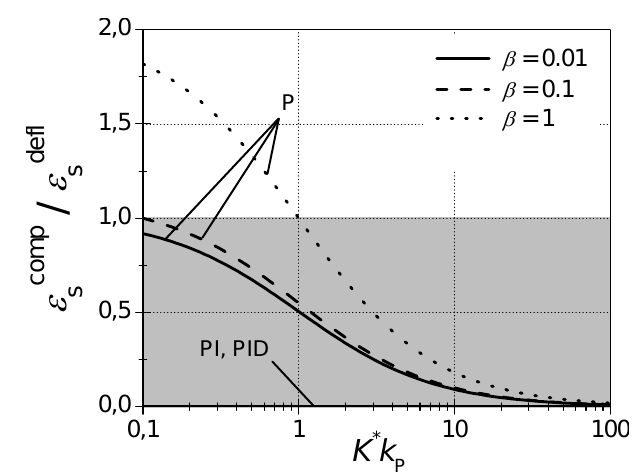
Figure 12. Ratio between systematic static deviations of the closed- loop sensor and the open-loop sensor versus the feedback factor K ∗ k P for a PT 1 -type sensor in combination with all three controller types. β indicates di ff erent deviation contributions from the feed- back elements compared to the deviation of the sensor itself.